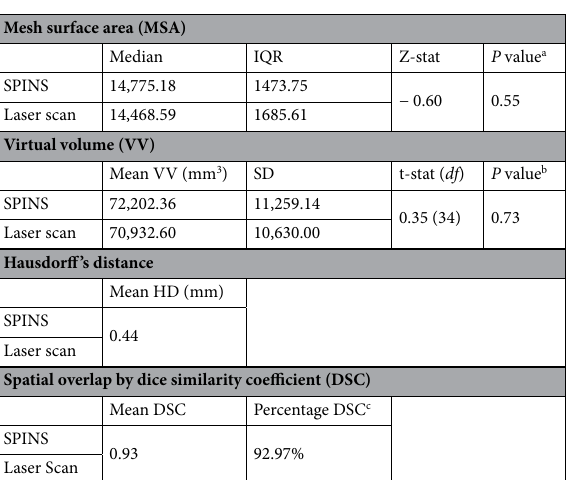
Table 1. Comparison of virtual properties between SPINS and laser scanned defect models. a